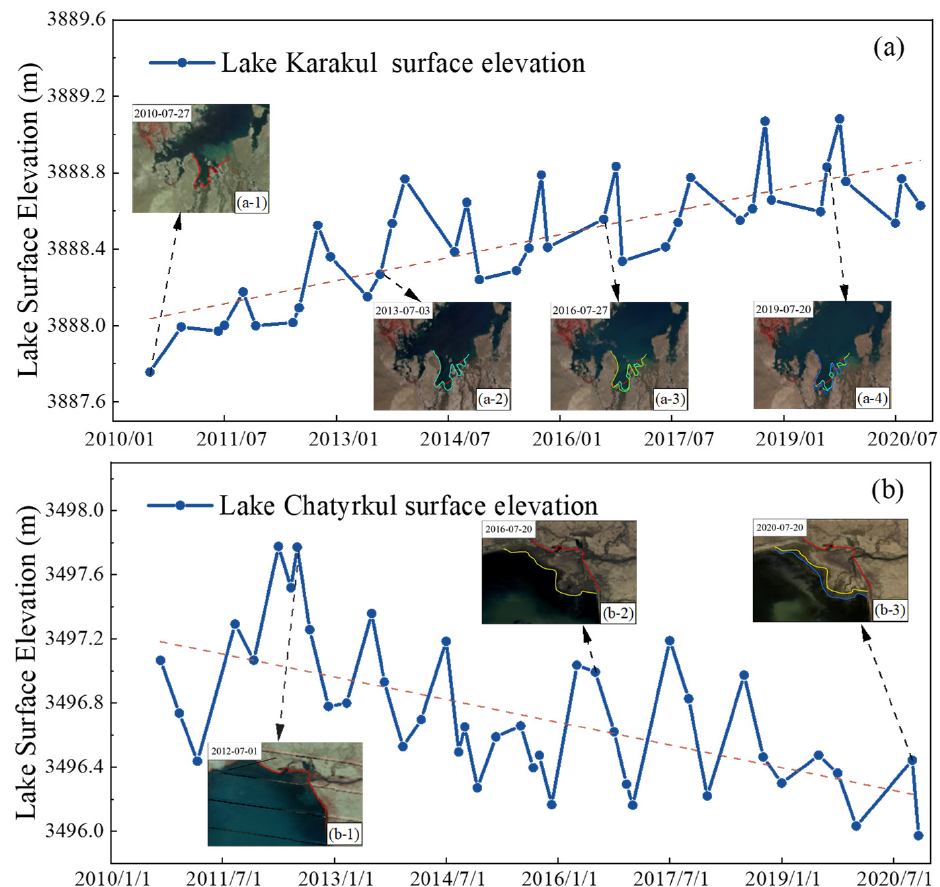
Figure 4. ( a ) Time series of the surface elevation of Lake Bosten based on CryoSat-2 satellite and Hydroweb data. ( b ) Time series of the surface elevation of Lake Issyk-Kul based on CryoSat-2 satellite and Hydroweb data.